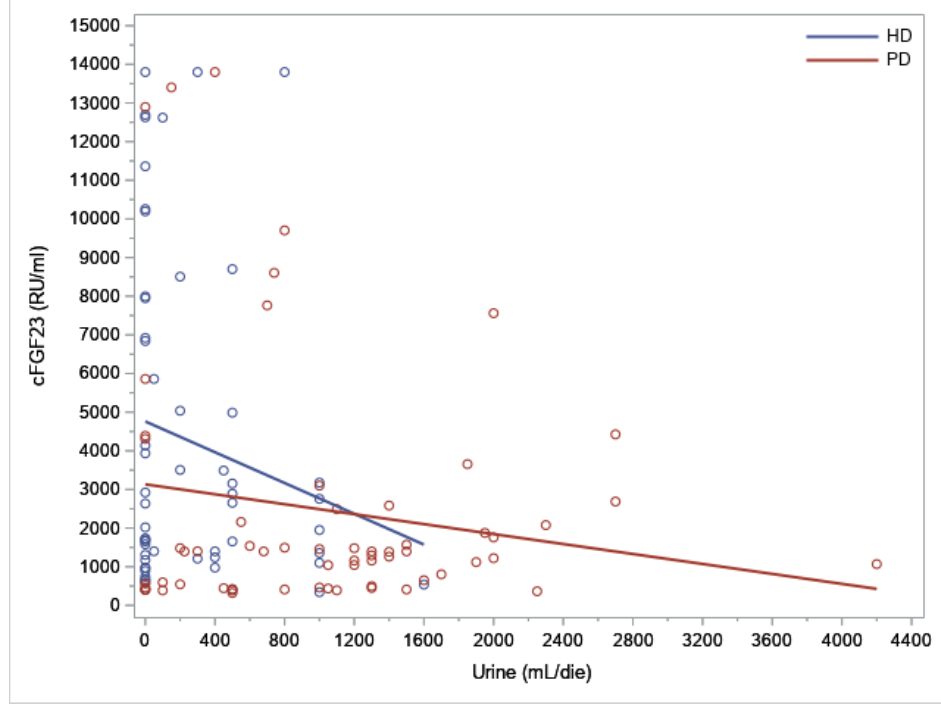
Figure 2. Scatter plot of the cFGF23 levels and residual urine output (UO) volume with the regres- sion line and Spearman ’s correlation coefficient.